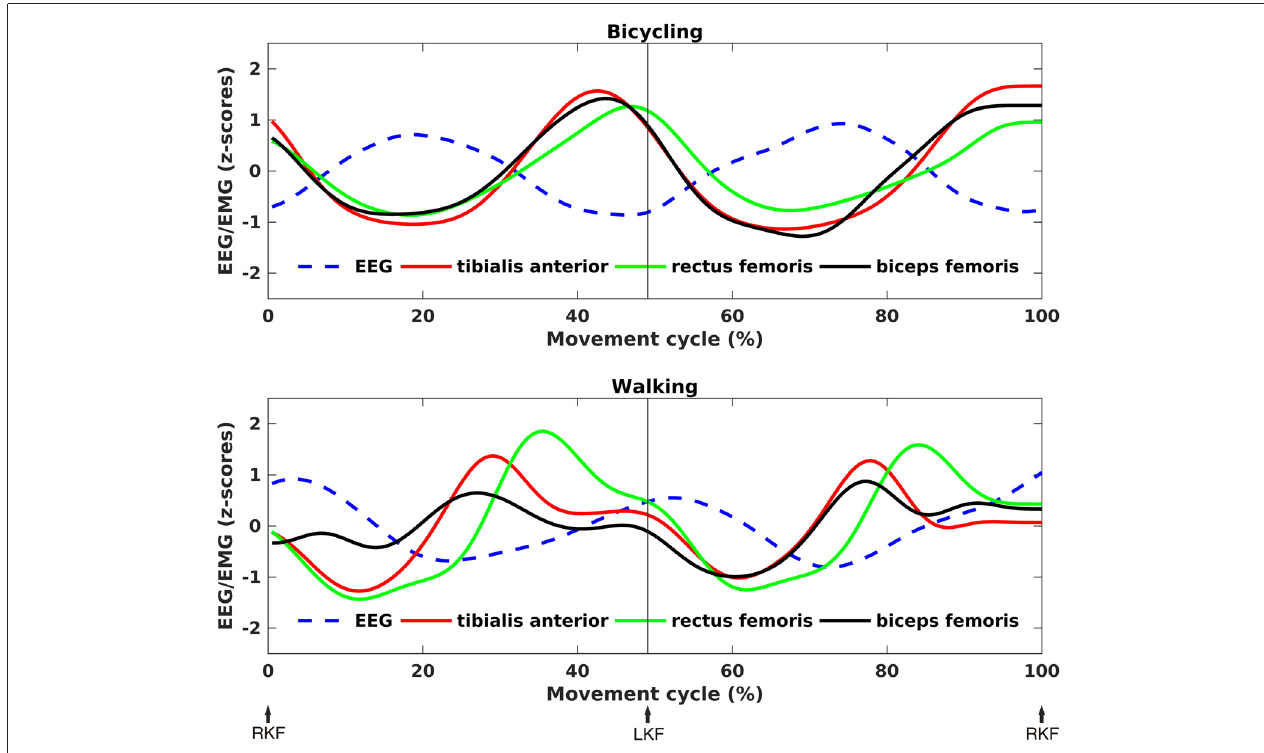
FIGURE 5 | Correlation between EEG power and EMG activity . Grand average z -score transformed, time-resolved EEG power and EMG activity for bicycling (upper panel) and walking (lower panel). The frequency was subject-specific, i.e., the frequency of maximal movement phase modulation in each individual. An anti-phasic relationship between EEG and EMG can be seen, with EMG activity peaks coinciding with EEG power